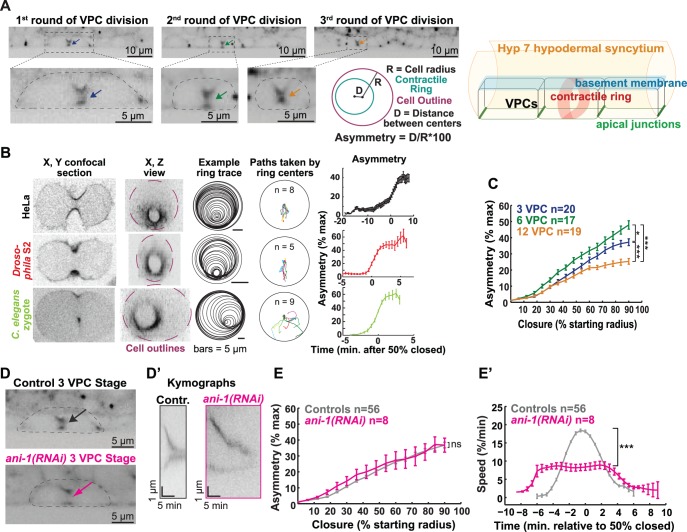
Strong intercellular adhesion leads to robust asymmetric contractile ring closure in the VPCs.(A) First (left), second (middle) and third (right) rounds of VPC cytokinesis in myosin::GFP worms. First round dividing cell reproduced from Figure 3A for ease of comparison. Scale bar = 10 µm. Dotted boxes and outlines: dividing cells; arrows: contractile rings. Scale bar = 5 µm. Representation of ring annotation and the parameters quantified: red = cell outline; green = contractile ring; R = cell radius; D = distance between cell and ring centers; Asymmetry = D/R*100. 3D schematic of contractile ring closure in the VPCs. (B) First column: x, y view of dividing HeLa cell (top), Drosophila S2 cell (middle), and C. elegans zygote (bottom). Second column: corresponding x, z views. Third column: example contractile ring location over time. Scale bar = 5 µm. Fourth column: the path taken by the ring for all examples of each cell type. Last column: asymmetry versus time. (C) Average asymmetry of furrowing over the percentage of VPC ring closure (first round; purple, second; green and third; orange). First: n(cells) = 20, n(worms) = 11. Second: n(cells) = 17, n(worms) = 6. Third: n(cells) = 19, n(worms) = 8. Error bars = SEM. ***: p<0.0001, *: p = 0.03, unpaired t-test calculated at 80% closed. (D) Confocal images of control and ANI-1 depleted worms expressing myosin::GFP (3 VPC stage). Dotted lines: dividing cells; arrows: ingressing furrows. Scale bar = 5 µm. (D’) Kymographs of contractile ring closure for control (black) and ANI-1 depleted (fuchsia) worms expressing myosin::GFP. Vertical scale bar = 1 µm. Horizontal scale bar = 5 min. (E-E’) Average furrow asymmetry and ring closure speed (all three rounds of VPC cytokinesis). Control (grey), n(cells) = 56, n(worms) = 25. ani-1(RNAi) (fuchsia), n(cells) = 8, n(worms) = 4. Error bars = SEM. n.s.: p>0.1, unpaired t-test. ***: p<0.0001, unpaired t-test.